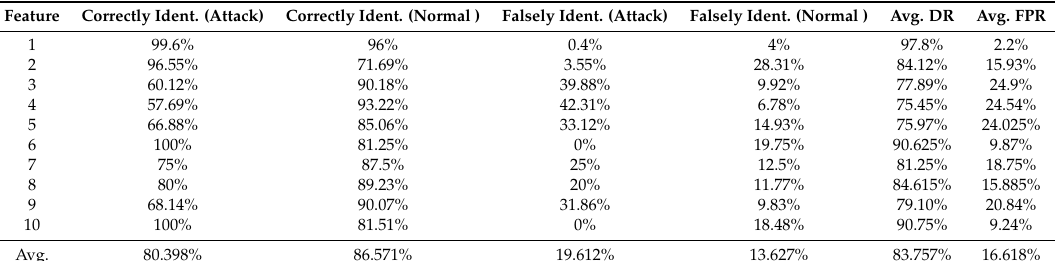
Table 4. Performance of Features using Isolation Forest on features in Table 2.